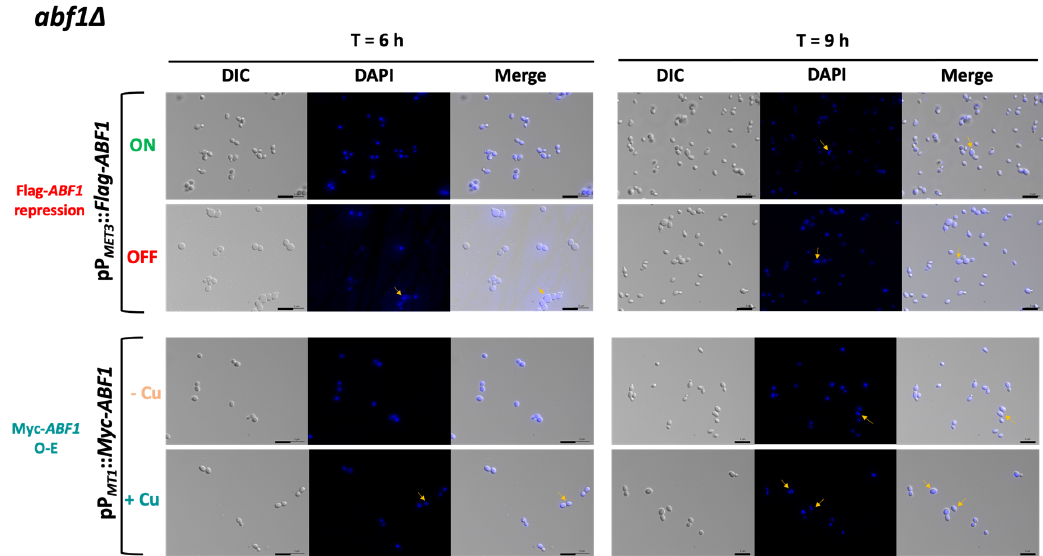
Figure 5. Cg Abf1 is required for nuclear integrity. Cells were grown to stationary phase in ON media; then, the OD 600 was adjusted to 0.5 and incubated at 30 °C in the following media depending on the strain: ON (in green, YNB minimal media) or OFF (in red, YNB plus 0.2 mM each cys and met) or in—Cu (in orange, YNB minimal media) or +Cu (cyan, YNB + 25 µM CuSO 4 ) as indicated. Samples were taken at 3, 6, and 9 h of incubation, stained with DAPI, and visualized and photographed under an Axio Imager.m2 fluorescence microscope. Images of the 6 and 9 hours are shown. Yellow arrows point to cells with nuclei defects. From left to right, DIC (differential interference contrast), DAPI (blue), Merge (DIC + DAPI). Scale bar corresponds to 5 µm.